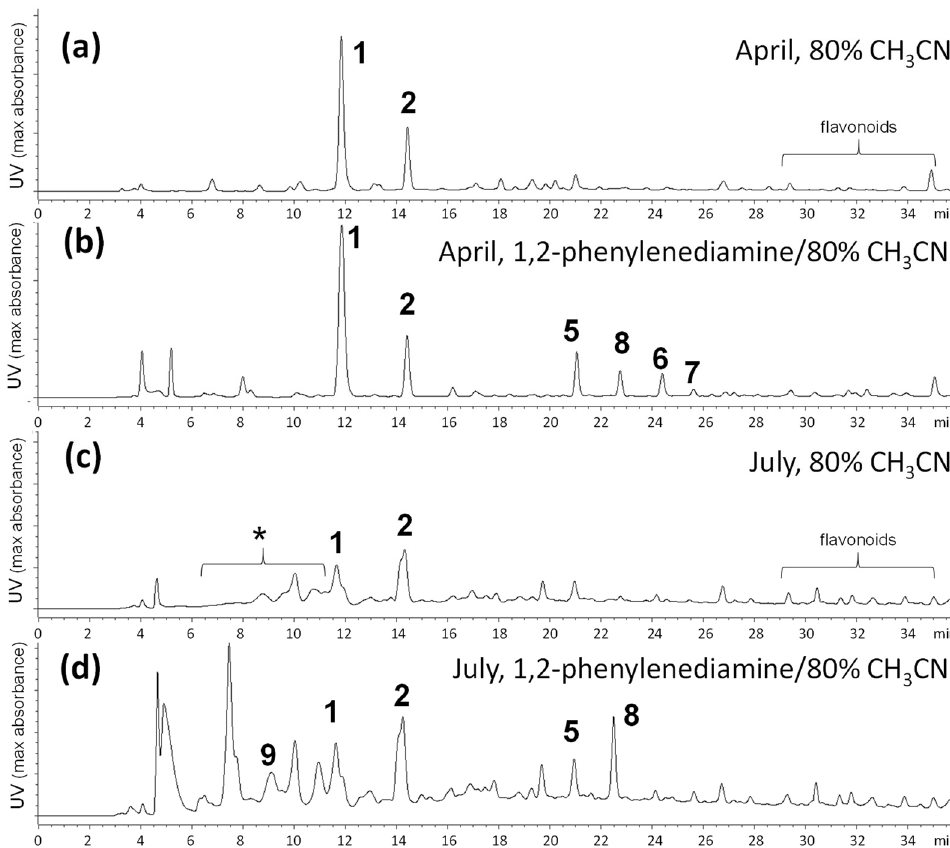
Figure 2. HPLC profiles of young (( a ) sample A and ( b ) sample B) and mature (( c ) sample C and ( d ) sample D) leaves of Q. dentata collected in April and July. ( a ) and ( c ): extracts with 80% CH 3 CN. ( b ) and ( d ): extracts obtained with 80% CH 3 CN containing 1,2-phenylenediamine and trifluoroacetic acid. The broad peaks marked with an asterisk are attributable to 9 and related compounds and oligomers of 1 and 2 .